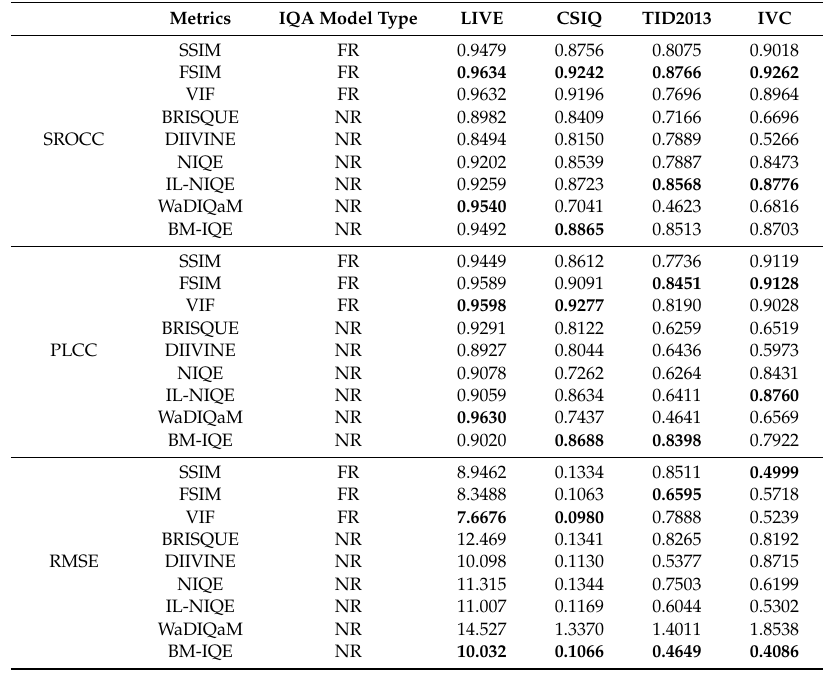
Table 6. The best-performing results of FR and NR classes are highlighted in bold. Table 6. Overall performance of FR / NR-IQA algorithms on LIVE, CSIQ, TID2013, and IVC databases.